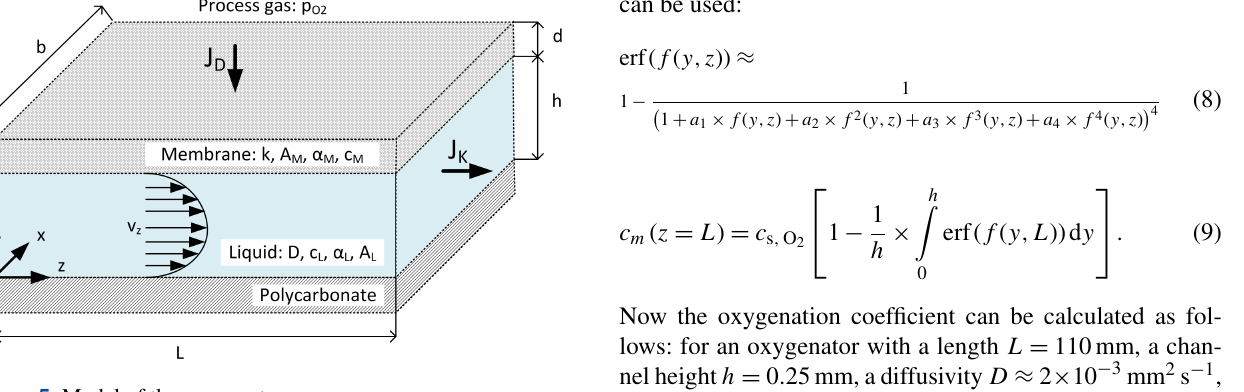
Figure 5. Model of the